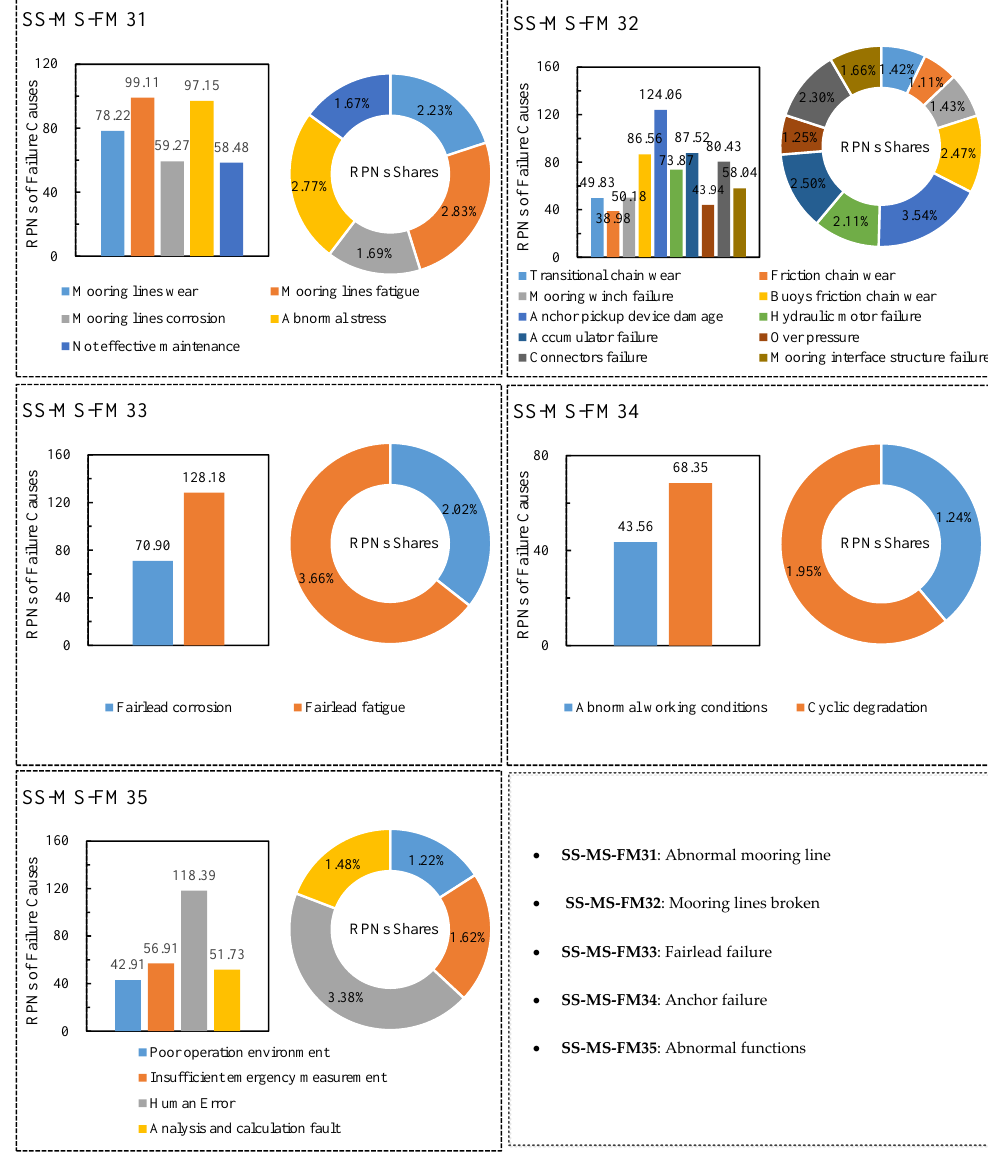
Figure 5. Failure features of the mooring system.